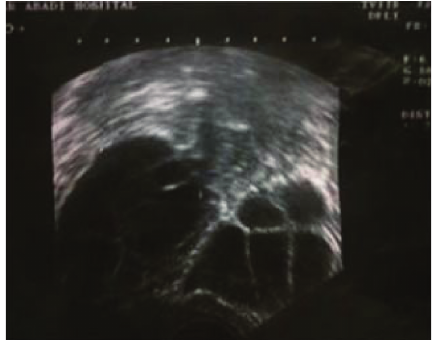
Figure 2: Ultrasound image shows bilateral ovarian multilocular cysts extending to the